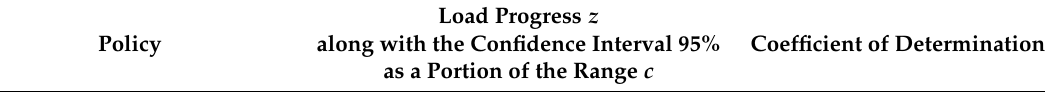
Table 1. Load progress z and Coefficient of Determination (COD) for the compared routing